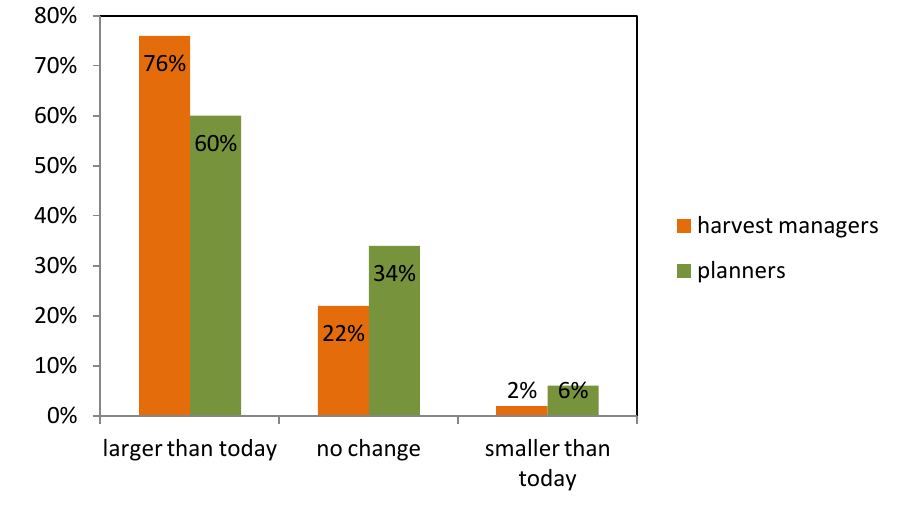
Figure 3. Desired changes in the size of the